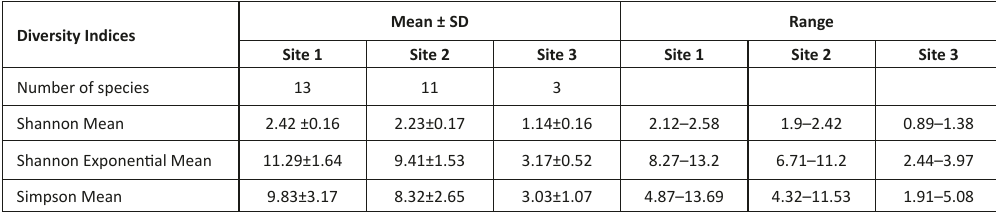
Table 2. Comparison of diversity indices within three ecosystems